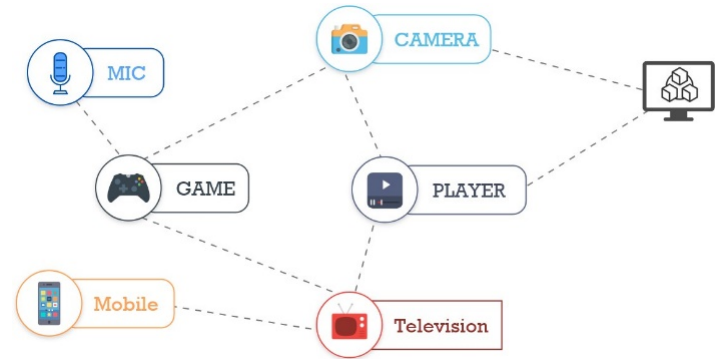
Figure 13. Blockchain in entertainment.